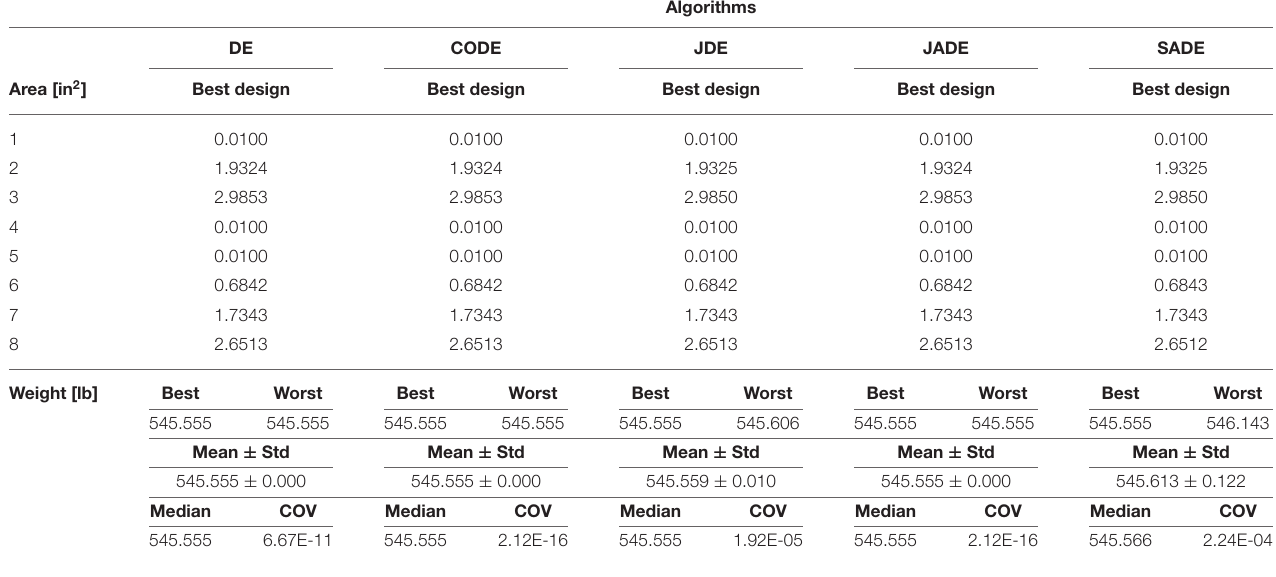
TABLE 4 | Algorithms’ statistical parameters for the 25-bar space truss problem.